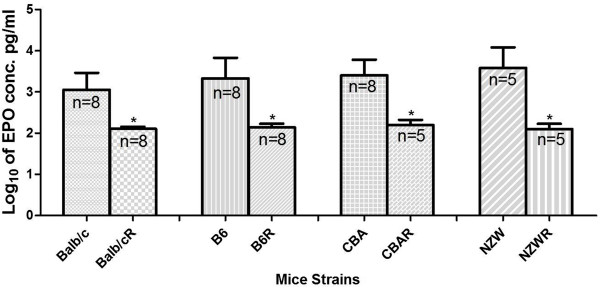
EPO levels in the semi-immune mice strains at infection and recovery. Blood was harvested for serum at minimum Hb at infection and at recovery. *Values at recovery are significantly lower than at infection for all the mice strains (p < 0.01). Values at recovery were not significantly different for all the mice strains. Recovery refers to time at which mice has been rested for two weeks after treatment with chloroquine/pyrimethamine for 6 days or until parasitaemia is zero. OD values from ELISA were converted to EPO concentration of pg/ml before it was transformed to log10. Values are means and errors bars being standard deviation (SD). Data was analysed by ANOVA after they were log transformed, with Tukey’s post test. n refers to number of samples. These are pooled data of two separate experiments.